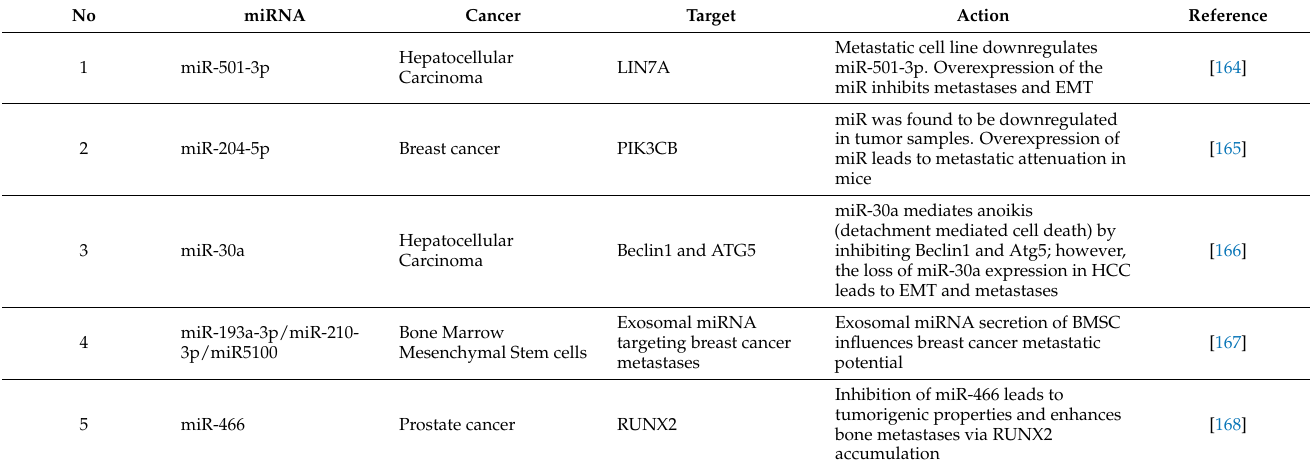
Table 8. The miRNAs implicated in invasion and